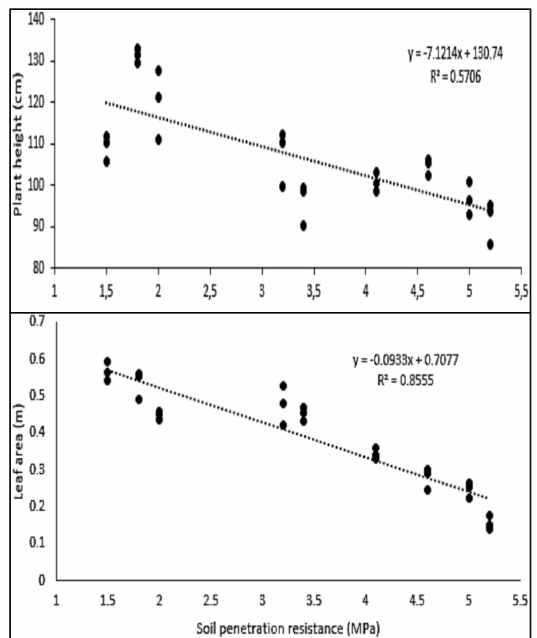
Figure 5. Effect of soil penetration resistance on the maize shoot height and leaf area 30 days after planting [95].